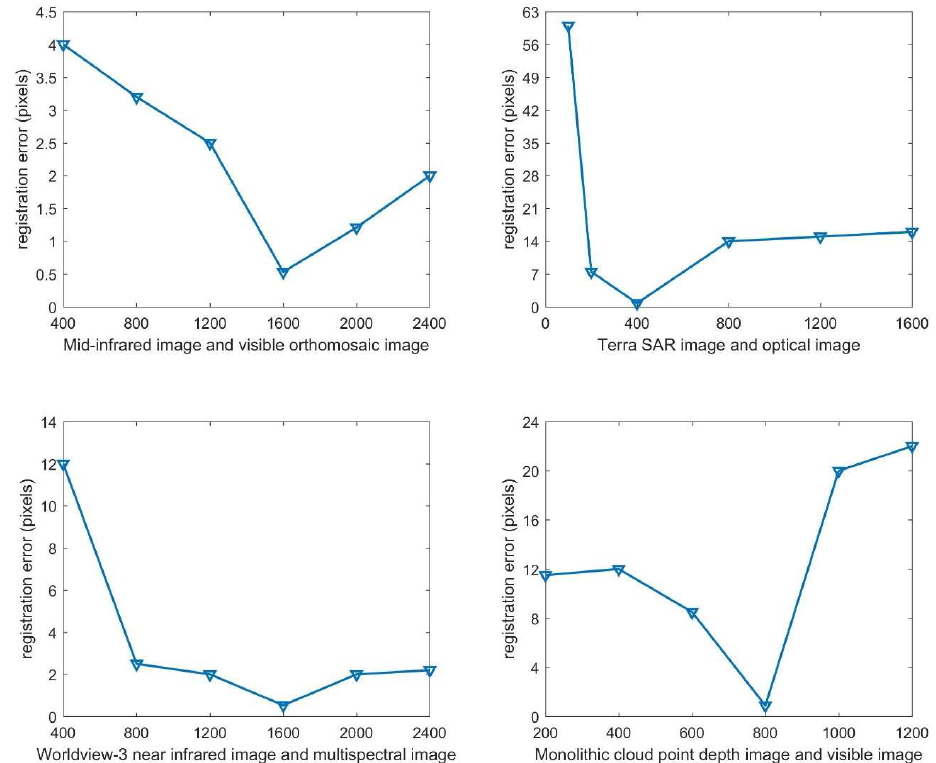
Figure 12 . Comparison with the weight of the regular term λ in four multimodal datasets. Figure 12. Comparison with the weight of the regular term λ in four multimodal